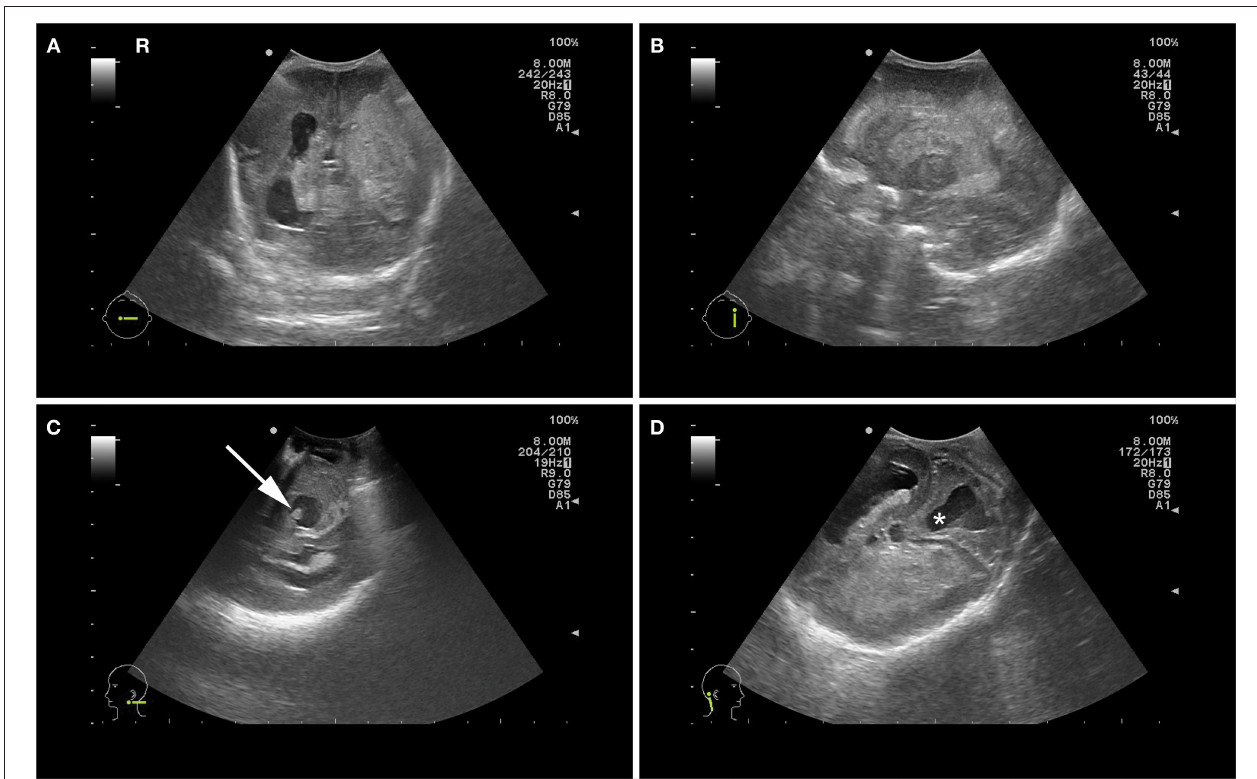
FIGURE 1 | Postnatal cranial ultrasound images showing bilateral intraventricular hemorrhage with extensive hemorrhagic infarction of the left hemisphere and ventricular dilatation in coronal view (A) and parasagittal left plane view (B) , blood clot in the 4 th ventricle (C) and dilatation of the 4 th ventricle ( * ) with dysplastic cerebellar hemispheres (D)